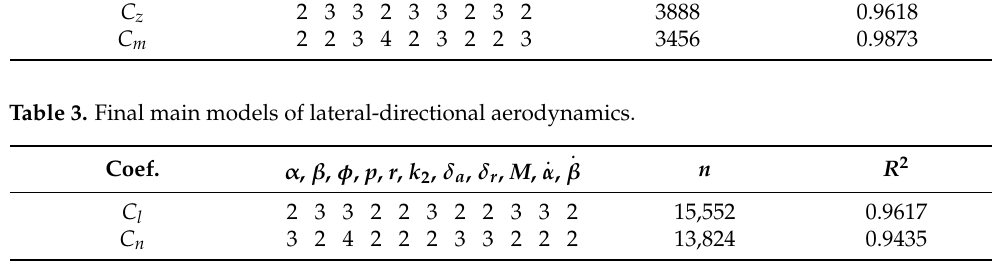
Table 2. Final main models of longitudinal aerodynamics. Coef.